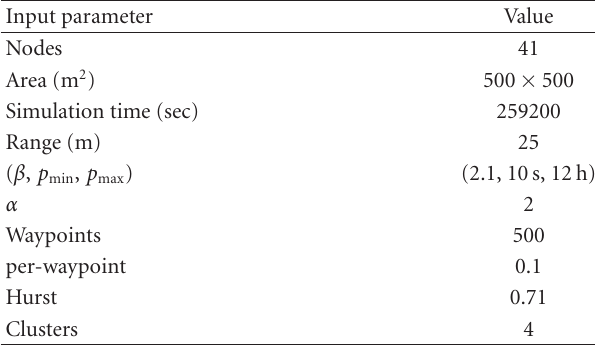
Table 3: Input parameter values of SLAW for the Infocom’05 sce- nario listed in Table 1. See [4] for details on the